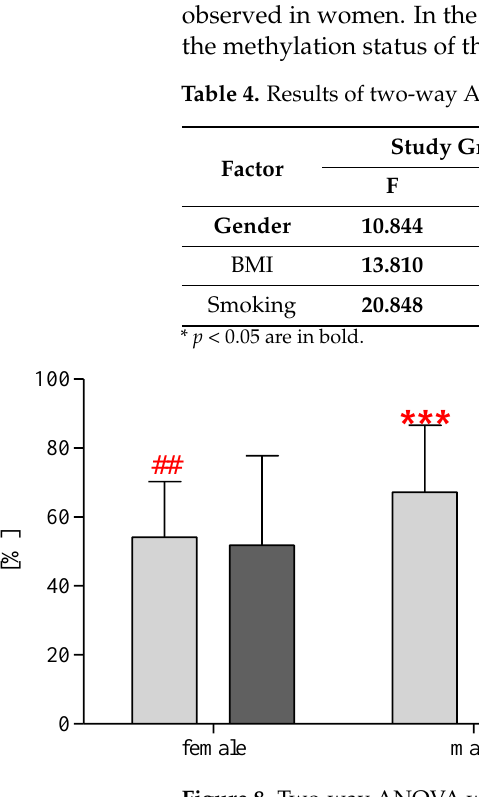
Figure 8. Two-way ANOVA with Bonferroni post hoc tests shows significant effects for gender and BC on the methylation level of the IL-6 promoter. The data are presented as mean ± SD.